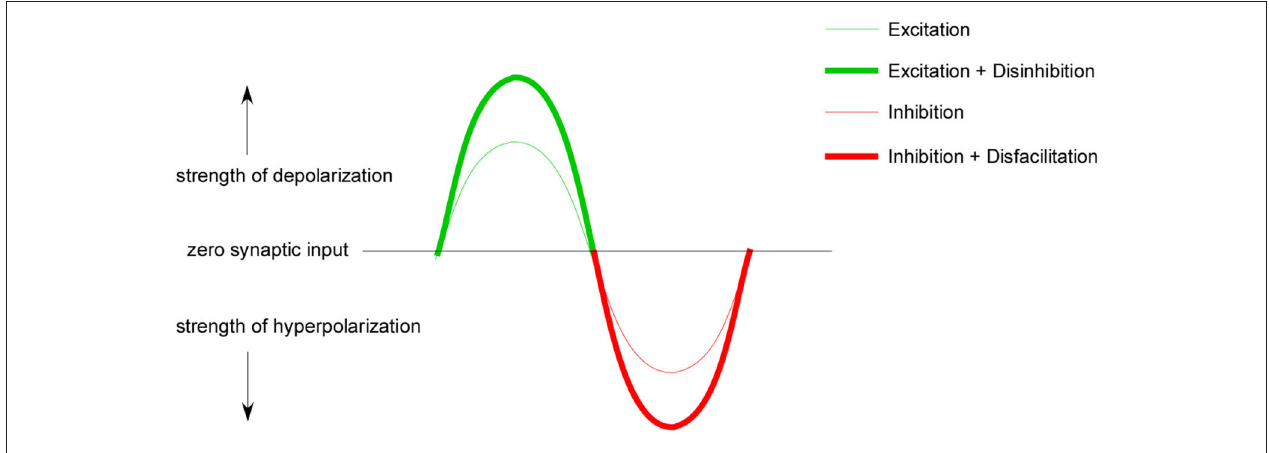
can couple with disfacillitation to increase inhibitory gain (thick red line). This conductance coupling can theoretically lead to a greater range of excitability modulation than excitation and inhibition alone (thin green/red